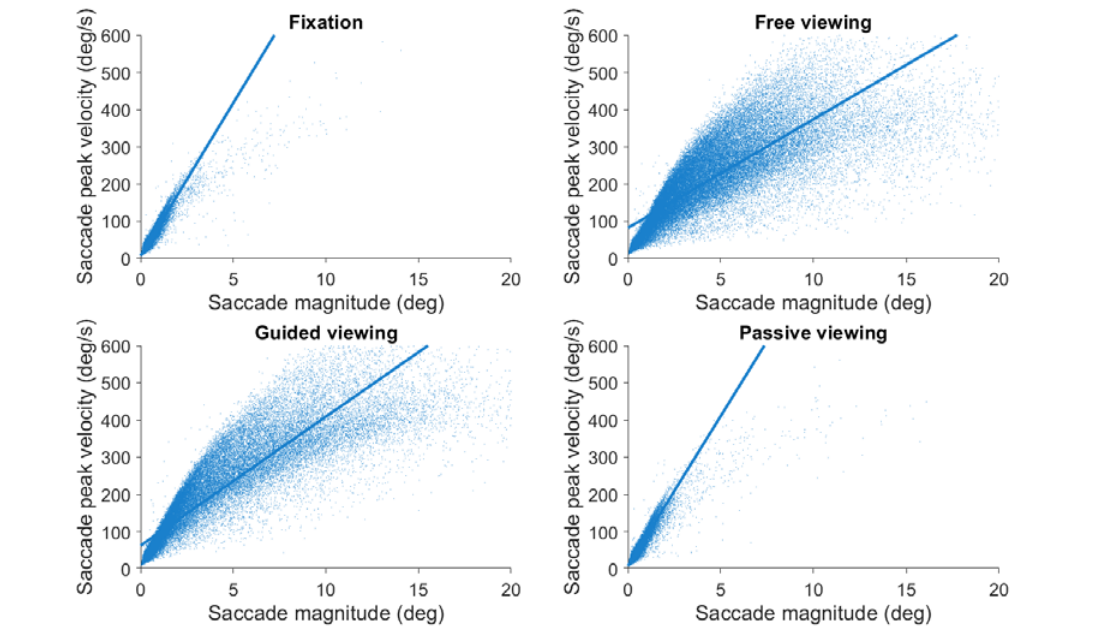
Figure 2. Main sequence relationship between (micro)saccade magnitude and peak velocity in each viewing